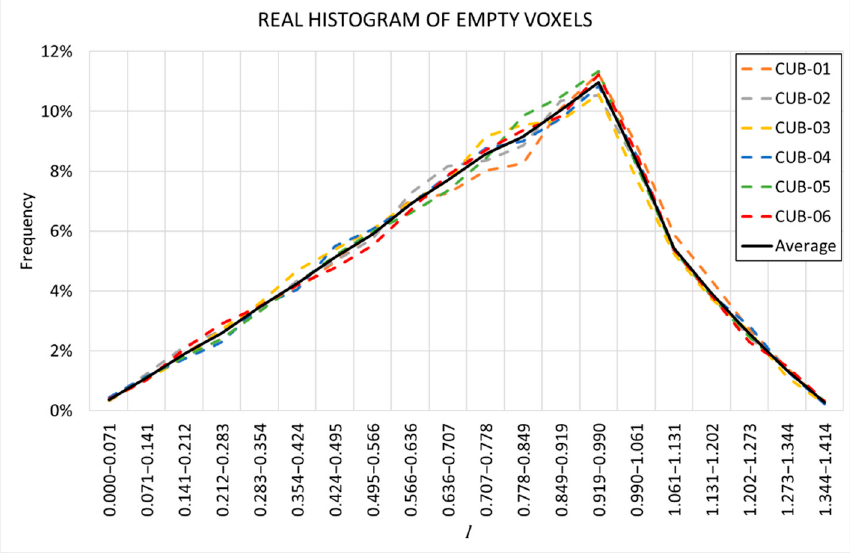
Figure 8. Circumferential test. Real histogram of empty voxels.